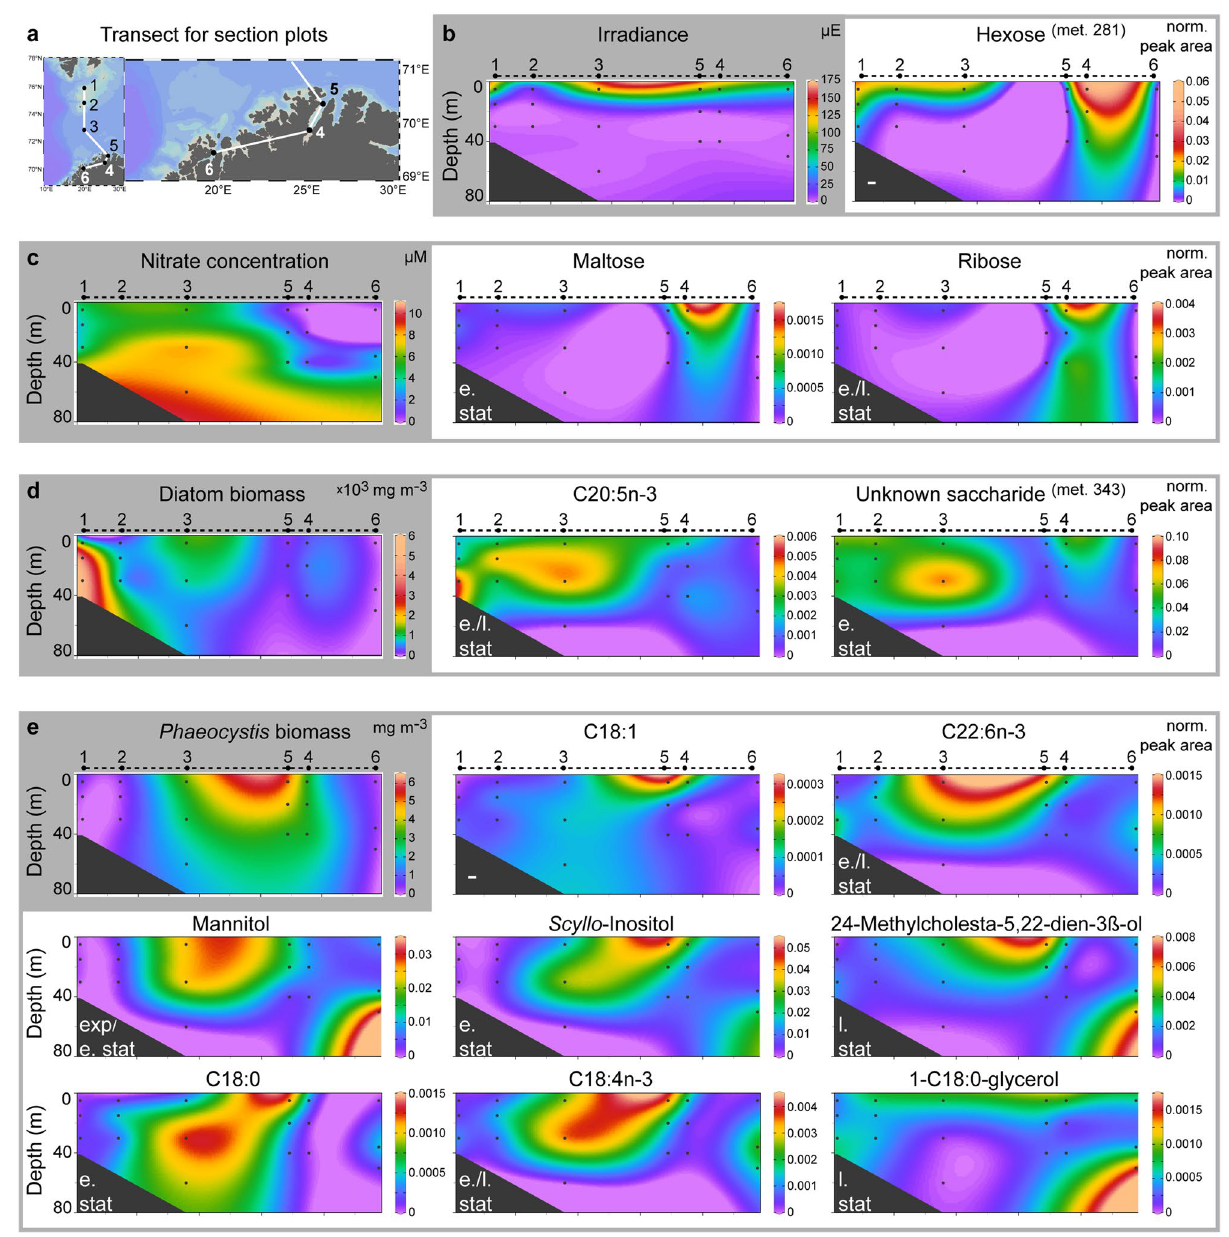
Figure 5. Relative abundance of P. pouchetii endometabolites within phytoplankton communities in the Barents Sea and North Norwegian fjords. ( a ) Transect along the PHAEONIGMA cruise stations 1–6 as used for section plots. ( b – e ) Section plots of metabolites that can be linked to species composition and environmental parameters (shaded in grey). Metabolites with similar occurrence patterns are grouped in grey boxes. ’Met.’— metabolite identifier within laboratory dataset. The growth phase of highest abundance for each metabolite is indicated (exp—exponential, e.stat—early stationary, l.stat—late stationary). The station map and section plots were generated using Ocean Data View (version 4.7.10, https